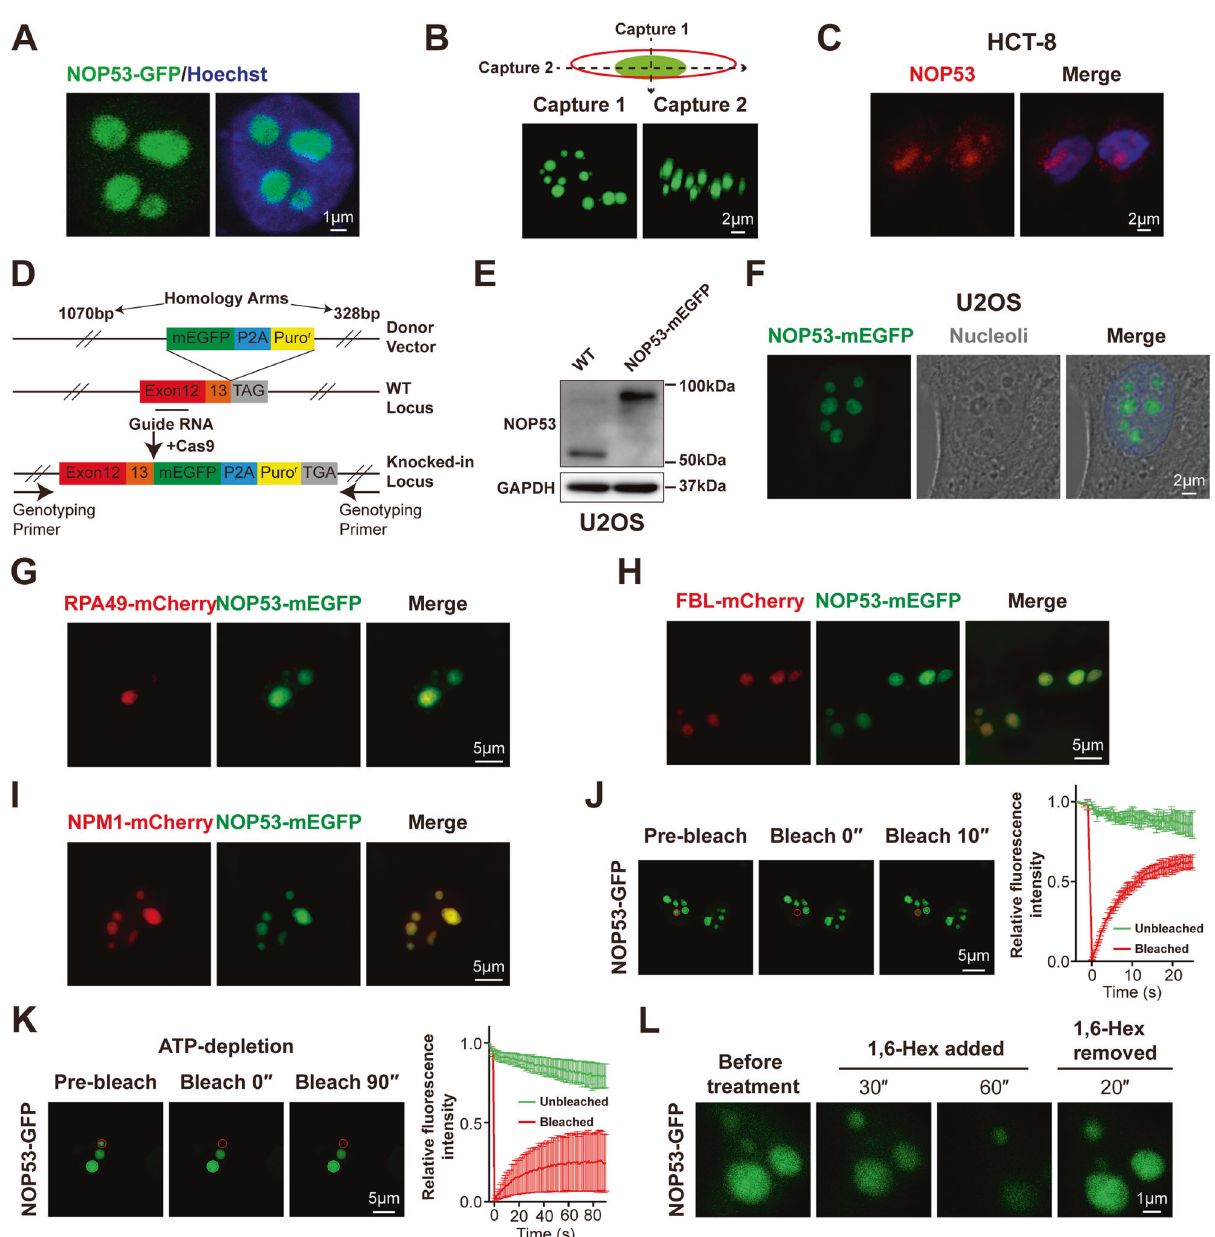
Fig. 1 NOP53 was localized in nucleoli and showed liquid-liquid phase separation property in cells. A NOP53-GFP showed puncta in nucleus of HEK293T cells. B HEK293T cells were imaged using Z-stack modular of Zeiss LSM880 to show the 3-dimentional image of NOP53 puncta. C Immuno fl uorescence of endogenous NOP53 in HCT-8 cells. D Experimental schematic of mEGFP-KI U2OS cell line. E mEGFP-KI U2OS cell line was veri fi ed by western blotting. F Endogenous NOP53-mEGFP showed puncta in the nucleolus of mEGFP-KI U2OS cell line. G – I NOP53-mEGFP was colocalized with NPM1-mCherry, but not with RPA49-mCherry and FBL-mCherry. HEK293T cells were transfected with plasmids for 24 h before observation using Nikon-Structured IIIumination Microscopy (N-SIM). J FRAP of NOP53-GFP puncta in HEK293T cells. The bleached punctum was highlighted with a red circle. K FRAP of NOP53-GFP puncta in ATP-depleted cells. The bleached punctum was highlighted with a red circle. For ( J and K ), n = 3 punctum analyzed in 3 independent experiments. Data are mean ± SD. L NOP53-GFP droplets were disrupted by 10% 1,6-hexanediol and recovered after removal of